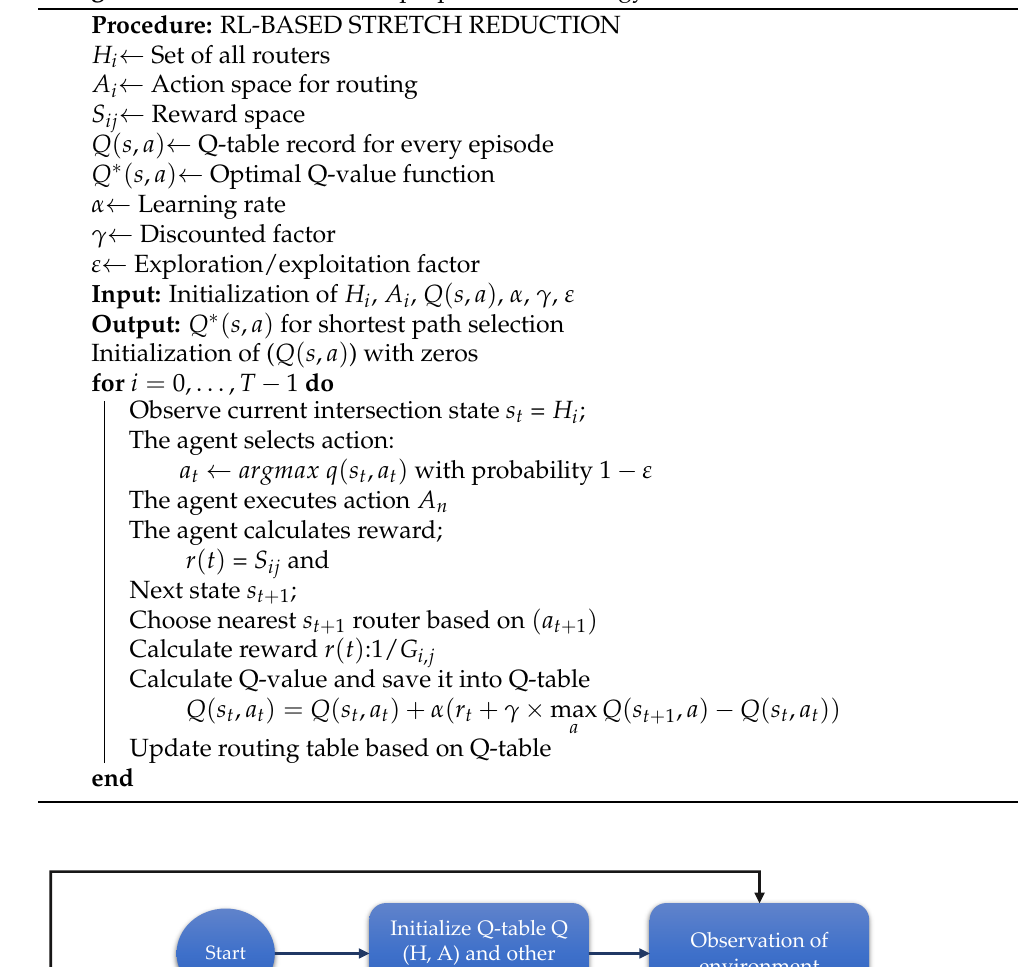
Algorithm 1: Pseudo-code for proposed ISO strategy.